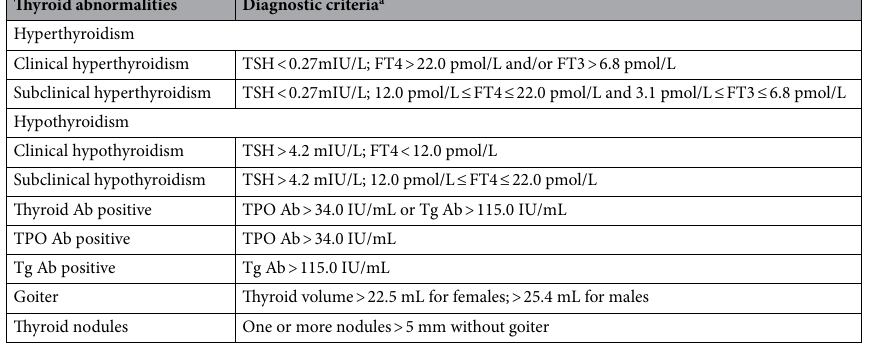
Table 3. Diagnostic criteria for thyroid abnormalities. TSH thyroid-stimulating hormone, FT4 free thyroxine, FT3 free triiodothyronine, TPO Ab thyroid peroxidase antibodies, Tg Ab thyroglobulin antibodies, Thyroid Ab thyroid peroxidase antibodies or thyroglobulin antibodies. a The normal reference range for TSH is 0.27–4.2 mIU/L; for FT4, 12.0–22.0 pmol/L; for FT3, 3.1–6.8 pmol/L; for TPO Ab, ≤ 34.0 IU/mL; for Tg Ab, ≤ 115.0 IU/ mL; for thyroid volume, ≤ 22.5 mL for females and ≤ 25.4 mL for